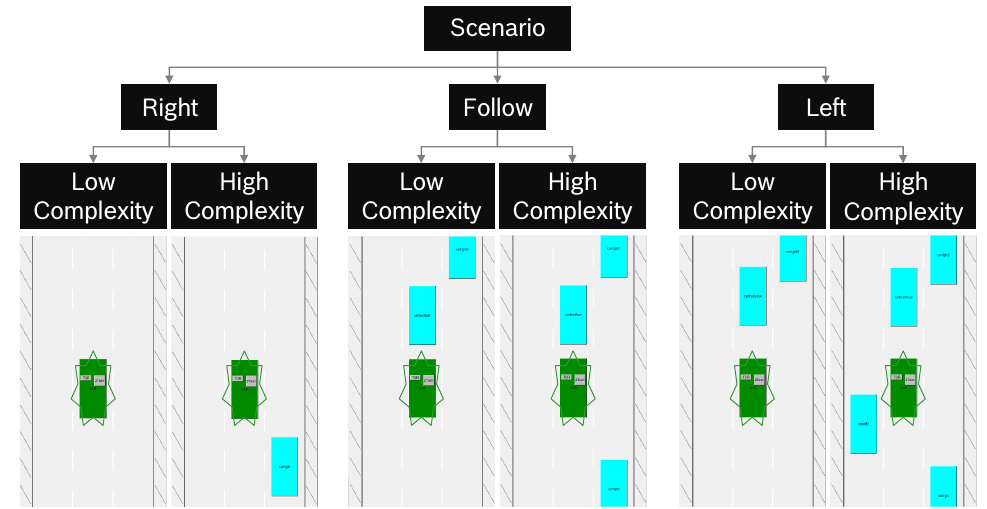
Figure 2. Representation of traffic scenarios in the graphical user interface representing the ego- vehicle (star-green) and relevant vehicles in the surrounding traffic environment at the takeover point (blue/green; source: own